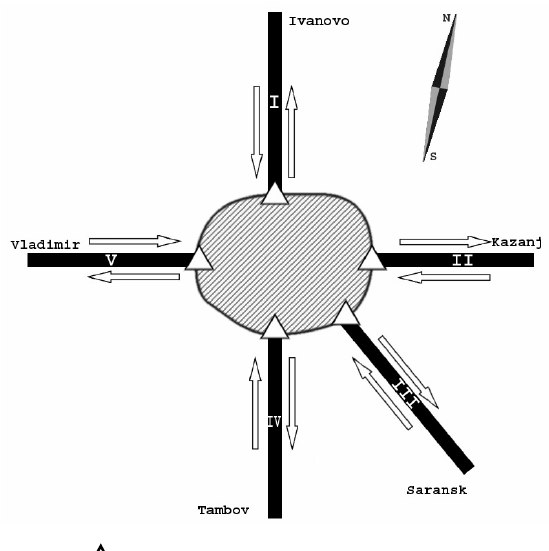
Fig 3. Vehicular transport hub (N. Novgorod`s hub terminals )